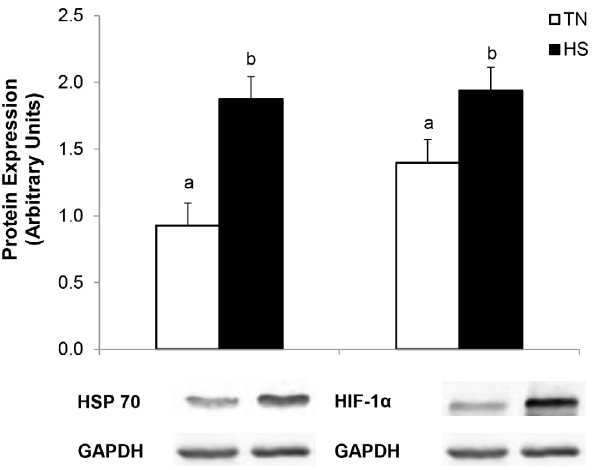
Figure 7. The effects of 24 hours of either constant thermal neutral conditions (TN; 21 u C) or heat stress conditions (HS; 35 u C) on a) mucosal HSP70 expression or b) mucosal HIF-1 a protein expression in growing pigs. a,b P , 0.05, n=8/trt.